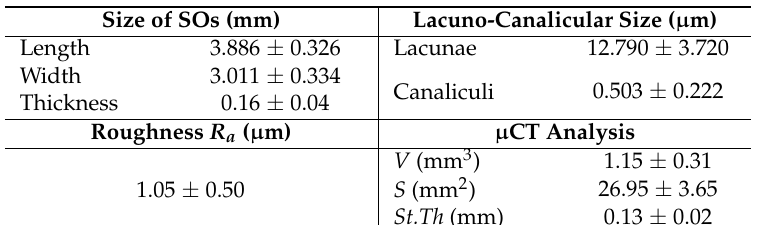
Table 1. Structural parameters of SOs.